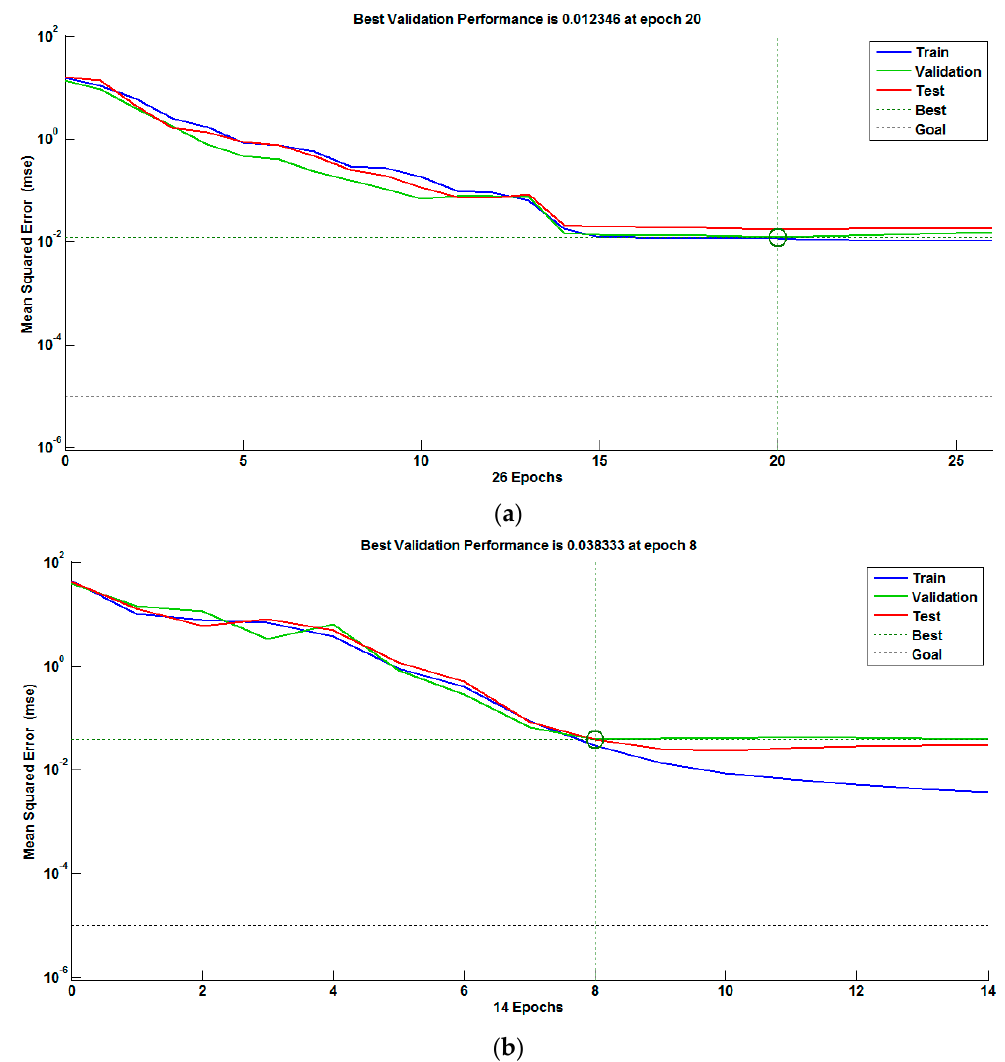
Figure 8. Best validation performance for the ( a ) single ( b ) double hidden layers.